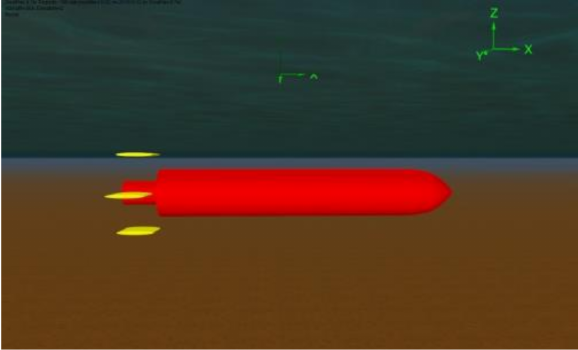
Figure 1. Schematic diagram of torpedo